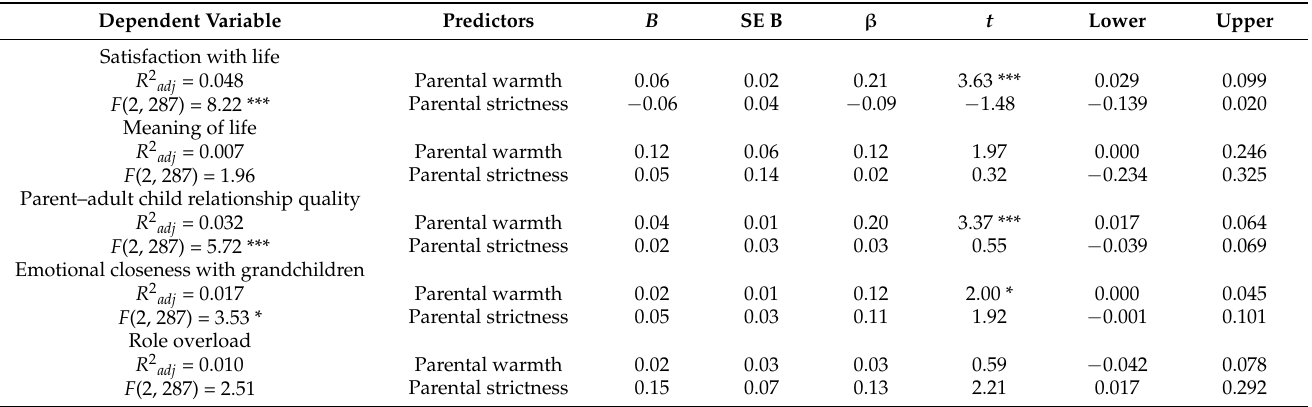
Table 2. Multiple linear regression coefficients between parenting dimensions and grandparenting